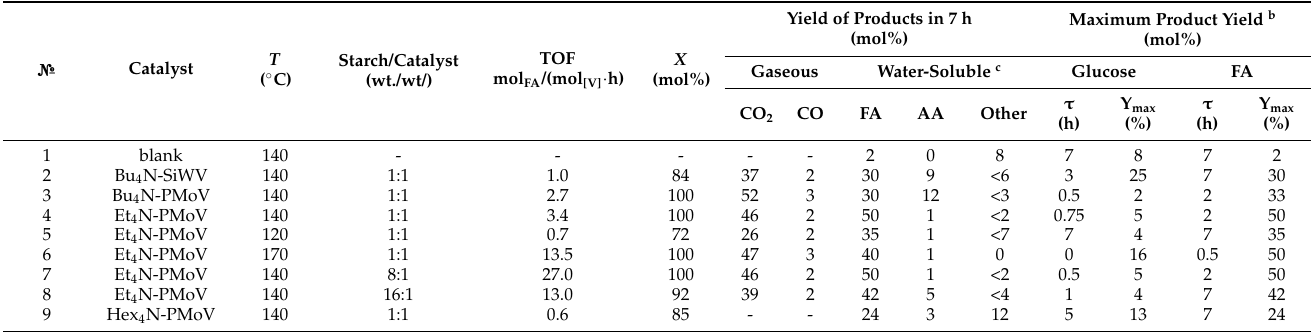
Table 2. Yield of products of hydrolysis-oxidation of potato starch in the presence of R 3.5 H 0.5 PMo 11 VO 40 salts a